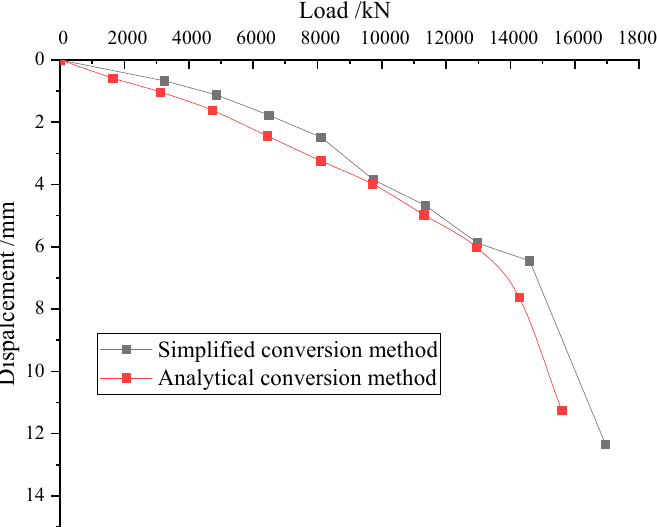
Figure 17. Comparison of Q-s curves of anchor pile method and different conversion methods.